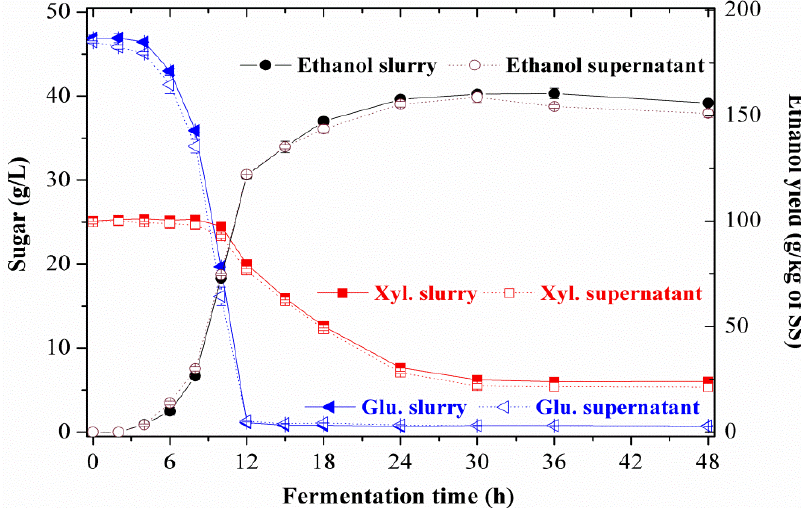
Figure 1. Sugar and ethanol concentration changed during fermentation with a Z. mobilis TSH-ZM-01 in both hydrolyzed slurry and